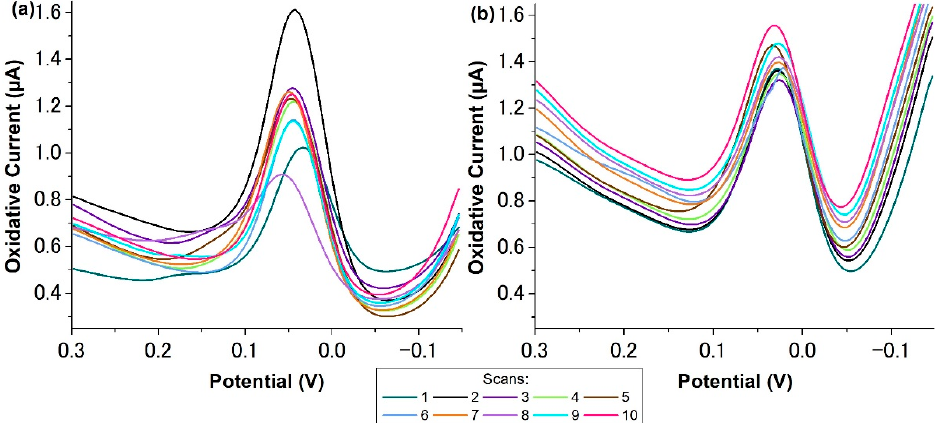
Figure 5. Ten SWVs with cleaning between each scan of ( a ) 25 μ M PAP on a single GSPE and ( b ) 3.8 μ M PAP on a single GSPE. At 25 μ M, a complete coating of PAP to the GSPE resulted in a large percentage difference of 88% between the smallest and largest peaks. Decreasing the PAP concen- tration to 3.8 μ M improved the reproducibility to a 19% difference between the smallest and largest peaks.